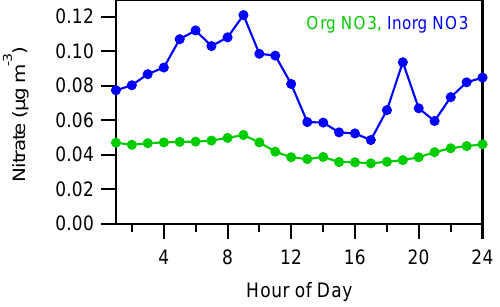
Figure 11. Diurnal cycles of organic and inorganic nitrate compo-